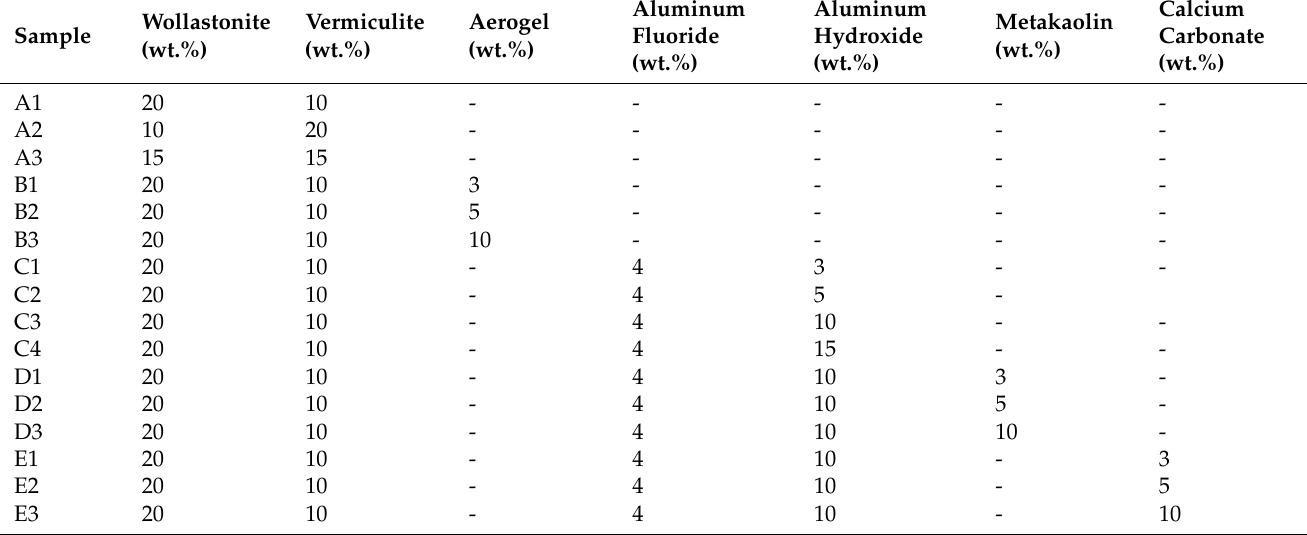
Table 1. The composition of the MKPC samples at M/P = 4 and W/C = 0.8.